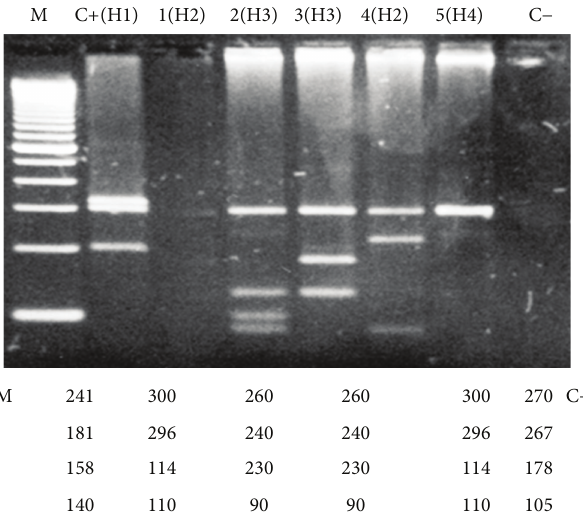
F 2: Digestion patterns with the enzyme HhaI found in some analyzed samples. Electrophoresis in 2 agarose gel 1000, stained